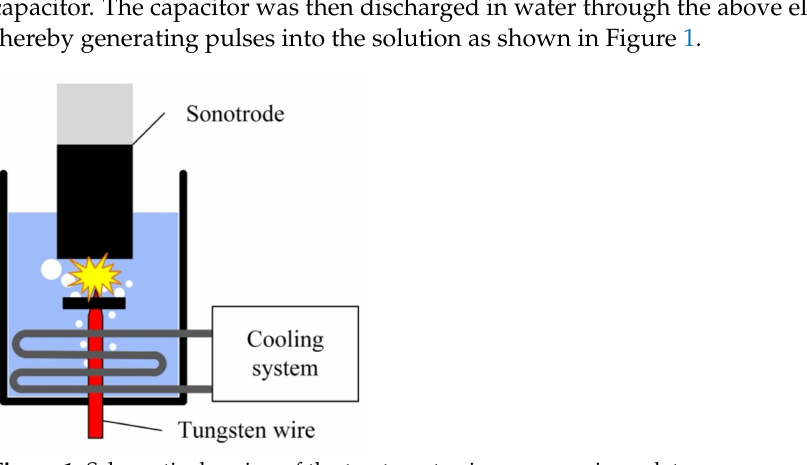
Figure 1. Schematic drawing of the treatment using a square iron